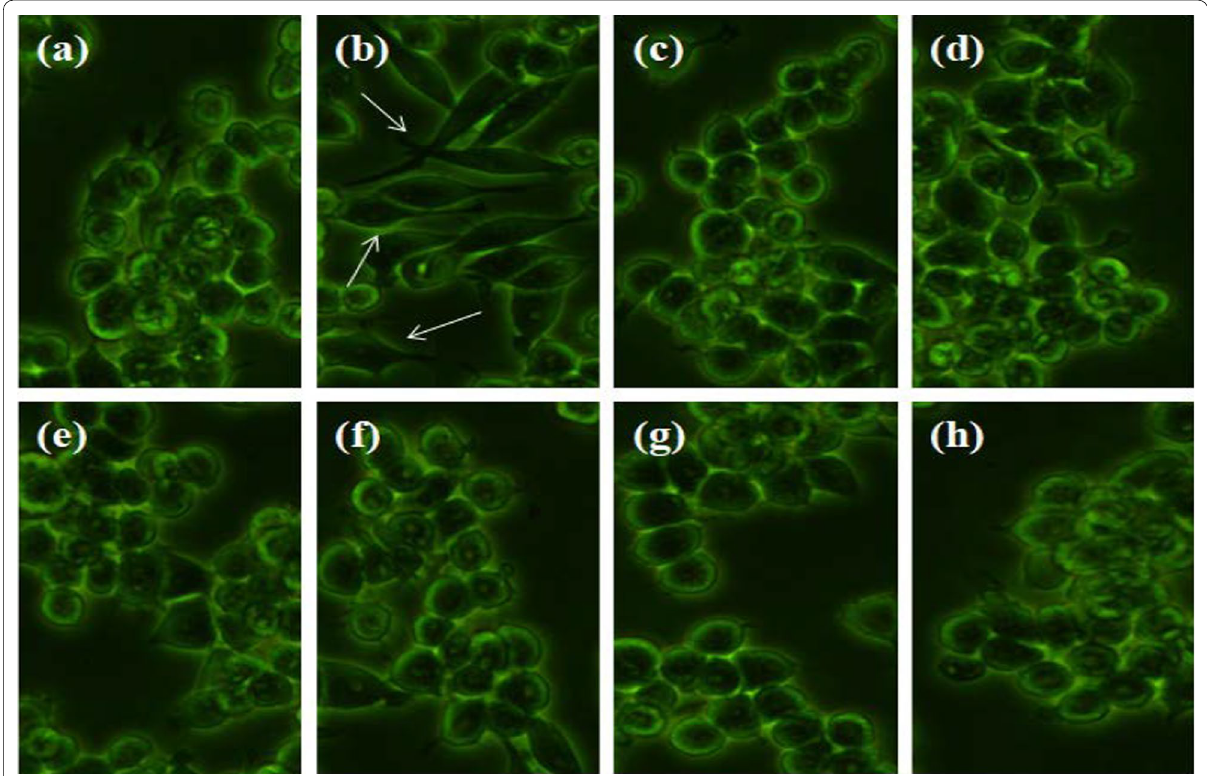
Fig. 6 Effect of different treatments on RAW264.7 murine macrophage cells. Changes of the morphology were observed under microscope and photographs were taken with Zeiss Zen blue inverted microscope. a Control, b LPS treatment, c GME(115 µg/ml) LPS treatment d GME(230 µg/ + ml) LPS treatment e Garcinol(6 µM) LPS treatment f Garcinol(12 µM) LPS treatment g HCA(17.5 µg/ml) LPS treatment h HCA(35 µg/ + + + + ml) LPS treatment. RAW 264.7 cells were cultured in 100-mm dishes at a density of 10 6 cells/cm 2 and allowed to settle for 16 h. After 16 h of + incubation, the medium was discarded and the cells were pre-treated as mentioned above. The cells were then stimulated with 1 µg/ml LPS for 24 h except for the control group. A typical experimental result of three independent experiments is